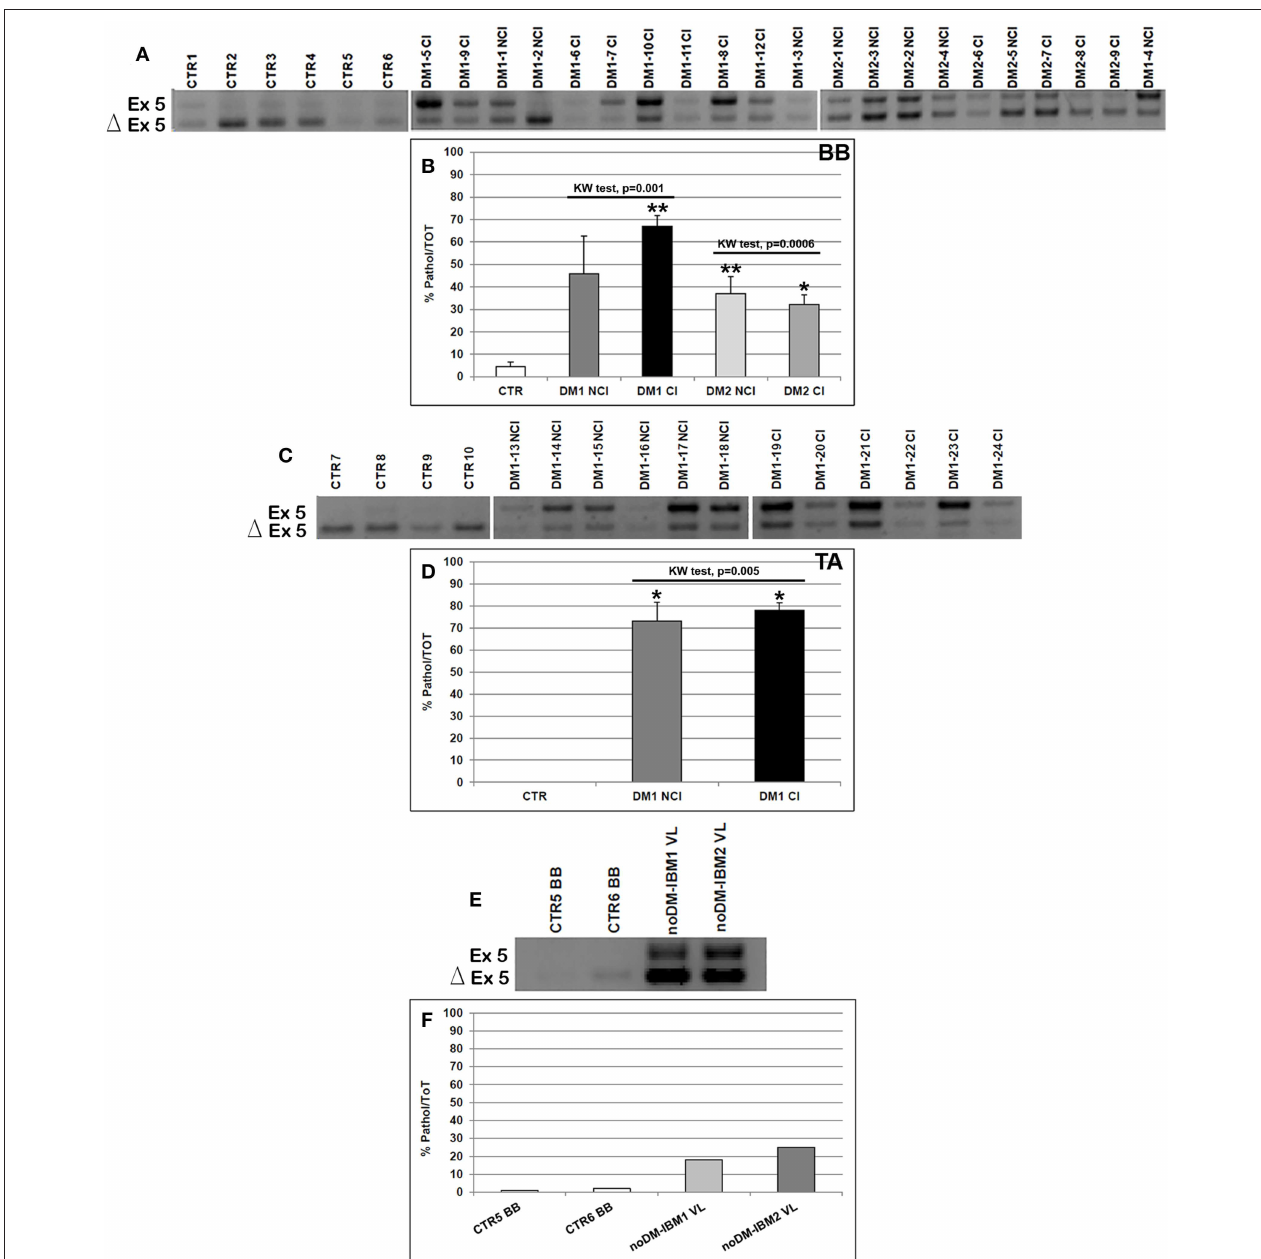
FIGURE 3 | (A–F) TNNT2 alternative splicing in skeletal muscle. (A,C,E) Panels showing the reverse transcriptase-polymerase chain reaction (RT-PCR) splicing assay of the TNNT2 gene in biceps brachii (BB) (A) and tibialis anterior (TA) muscle samples (C) from CTR, DM1, and DM2 patients. DM1 and DM2 patient groups have been divided into two subgroups according to the presence of cardiac abnormalities: NCI, no cardiac involvement; CI, cardiac involvement. TNNT2 alternative splicing has been analyzed in vastus lateralis of patients affected by inclusion body myositis (noDM-IBM) (E) . The products that include the specific exon 5 (Ex) and those that exclude the specific exon 5 ( 1 ) have been indicated. (B,D,F) Analysis of the percentage of altered isoform (exon 5 including) expression of the TNNT2 gene in BB (B) , TA (D) , and in noDM-IBM muscle samples (F) . Histograms represent mean values and bars represent SEM. GAPDH has been chosen as the housekeeping, internal control. Each PCR reaction has been performed in triplicate. The differences between subgroups have been assessed by nonparametric, Kruskal – Wallis test. Results from Dwass, Steel, Critchlow – Fligner multiple post-hoc comparison procedure: NCI or CI subgroups vs. CTR, * p < 0.05, ** p < 0.01.